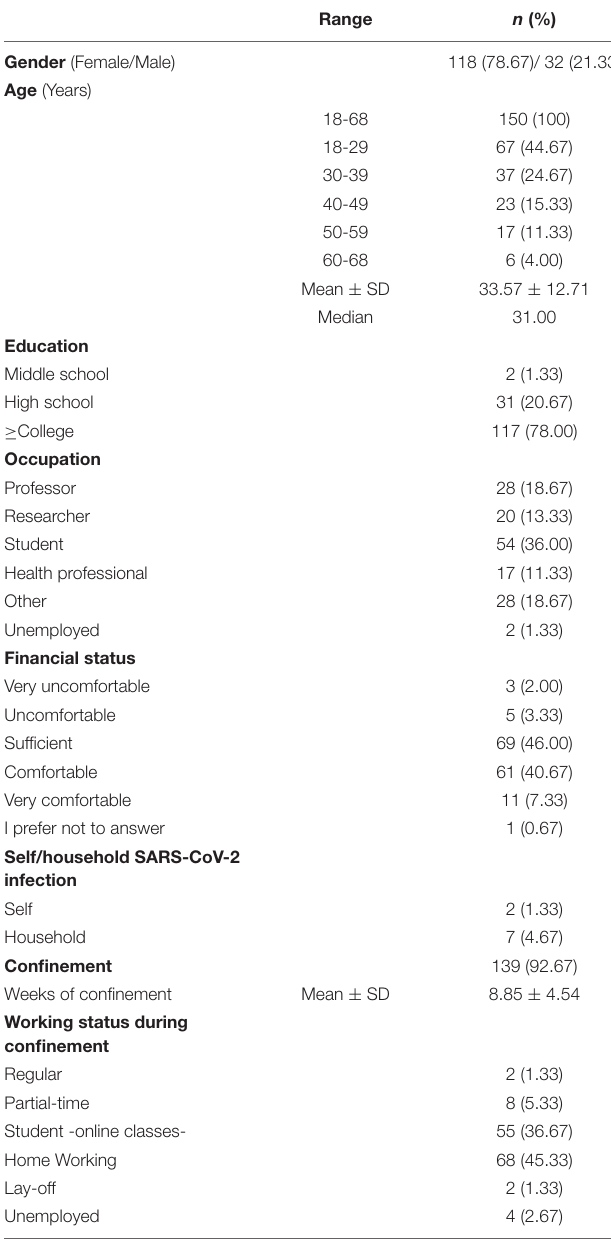
TABLE 1 | Socio-demographic characteristics ( n =